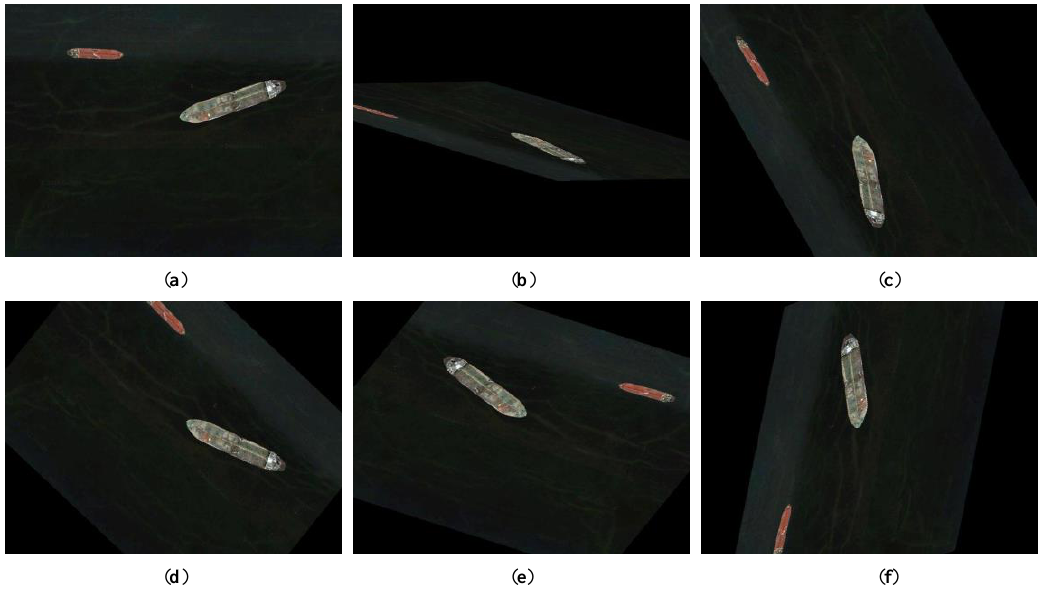
Figure 5. Images from different perspectives produced by the affine transformation of satellite remote sensing images. ( a ) Original image. ( b – f ) Different perspective images generated by affine transformation.